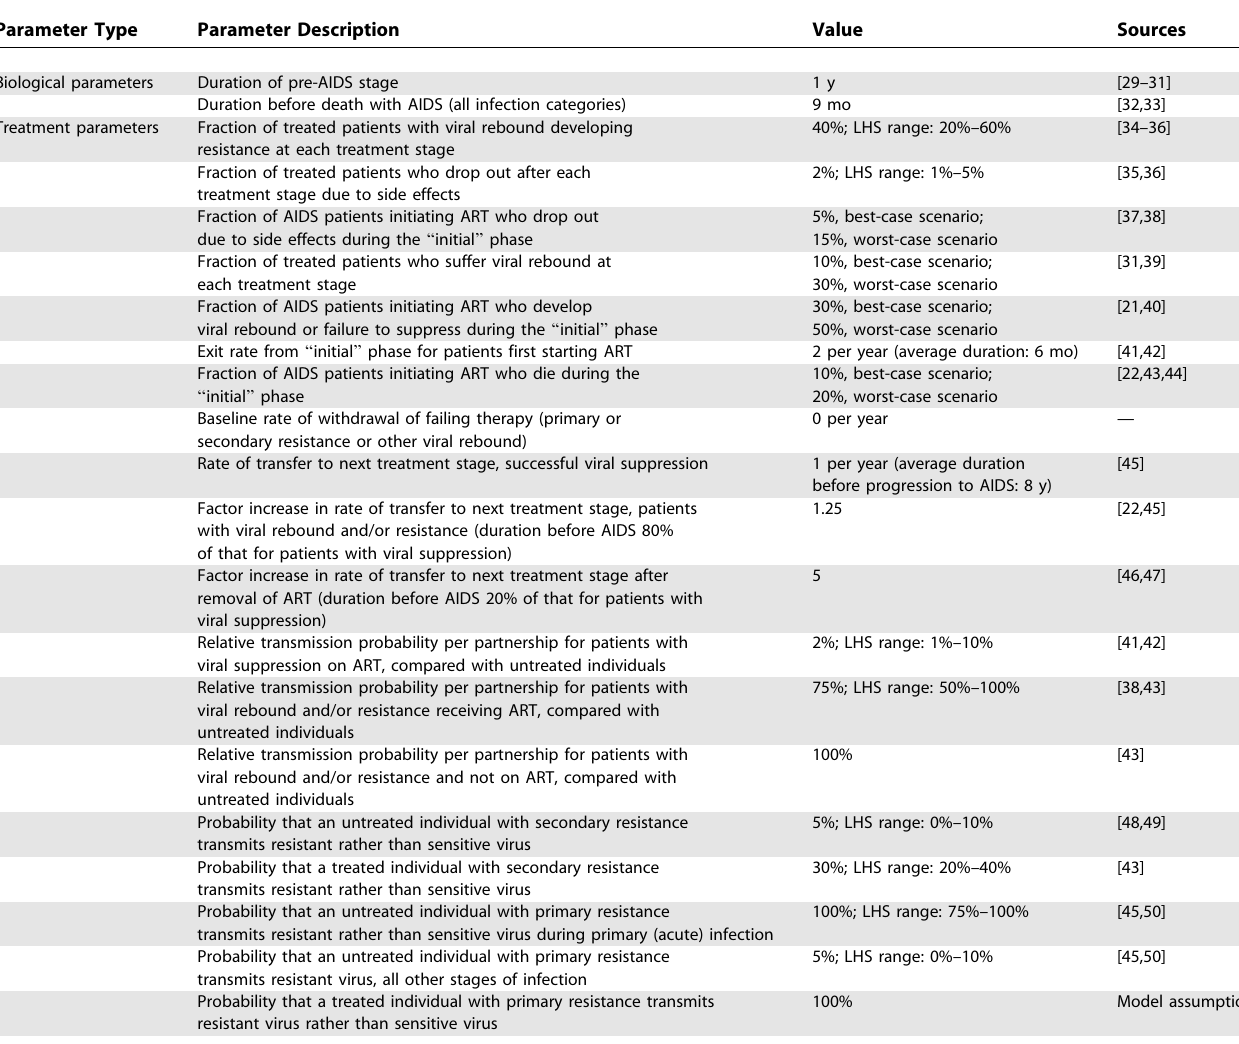
Table 1. Descriptions and Baseline Values of Some Key Model Parameters, with Sources Parameter